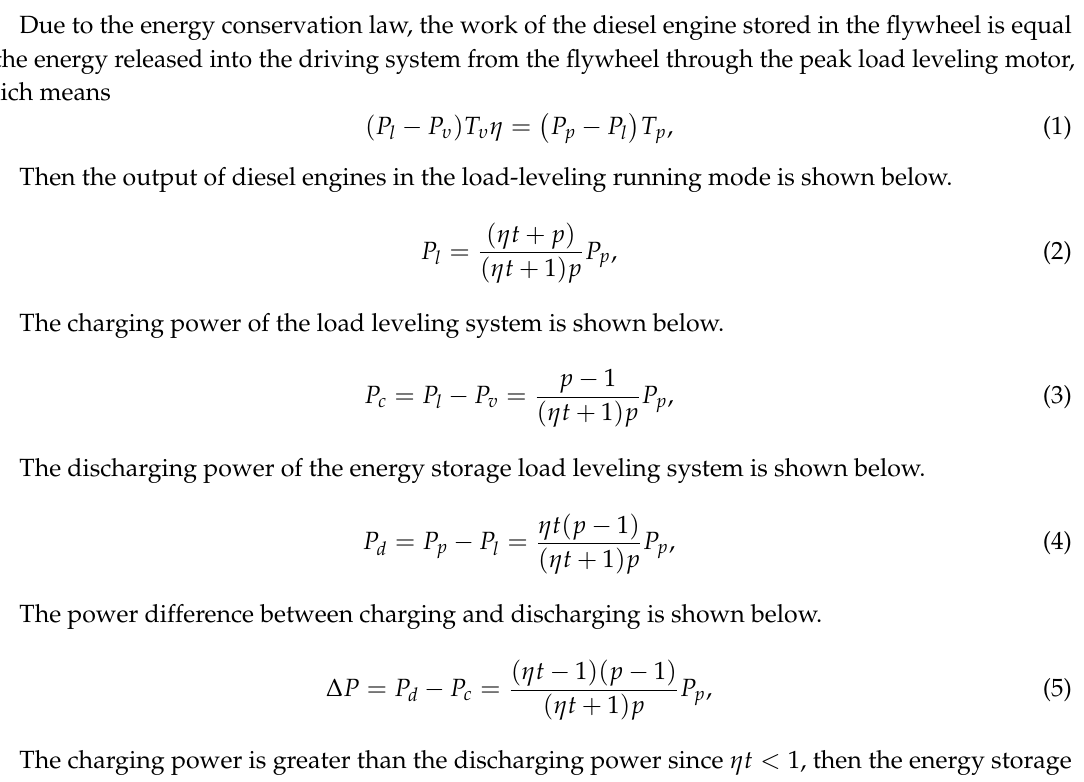
Figure 5. Fuel consumption scale to the power ratio.